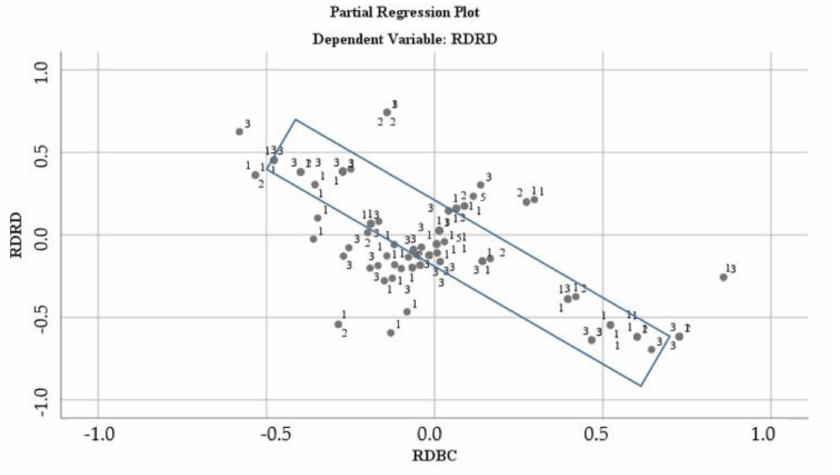
Figure 7. Regression analysis for